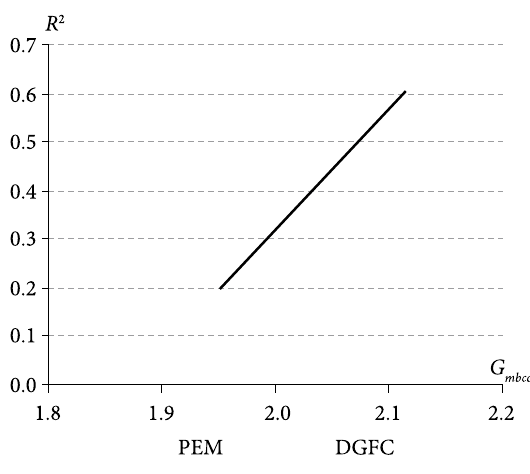
Fig. 15. R -square value of the correlation P CE = a 1 G mbcor + b 1